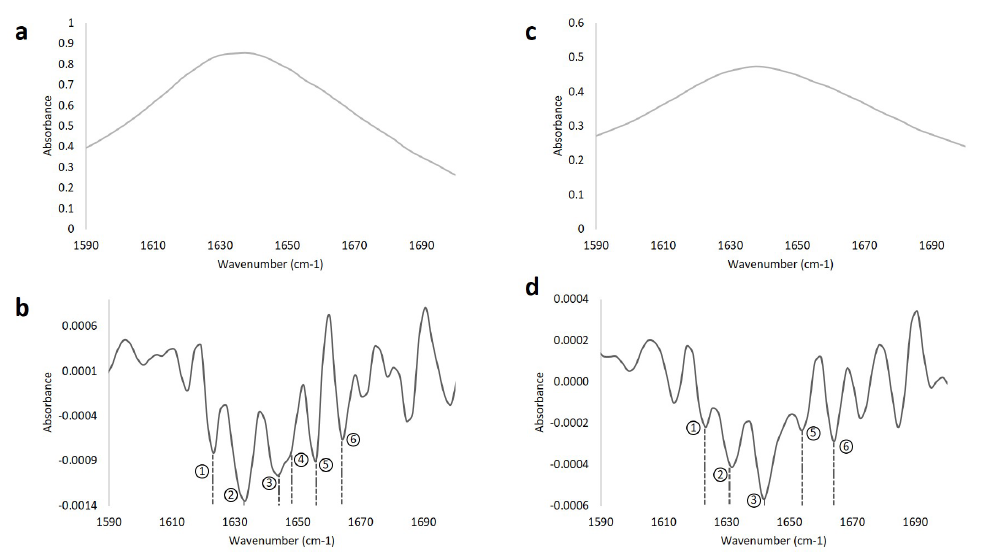
Figure 5. Average FT-IR and second derivative analysis of the amide I bond. ( a ) Amide I bond of free laccase, ( b ) second derivative of the amide I bond of free laccase, ( c ) amide I bond of immobilized laccase (IL), and ( d ) second derivative of the amide I bond of IL. The numbers 1, 2, and 3 correspond to change in the β -sheet structure. Number 4 corresponds to Random coil. Number 5 and 6 correspond to α -helix and 310-helix structure, respectively.